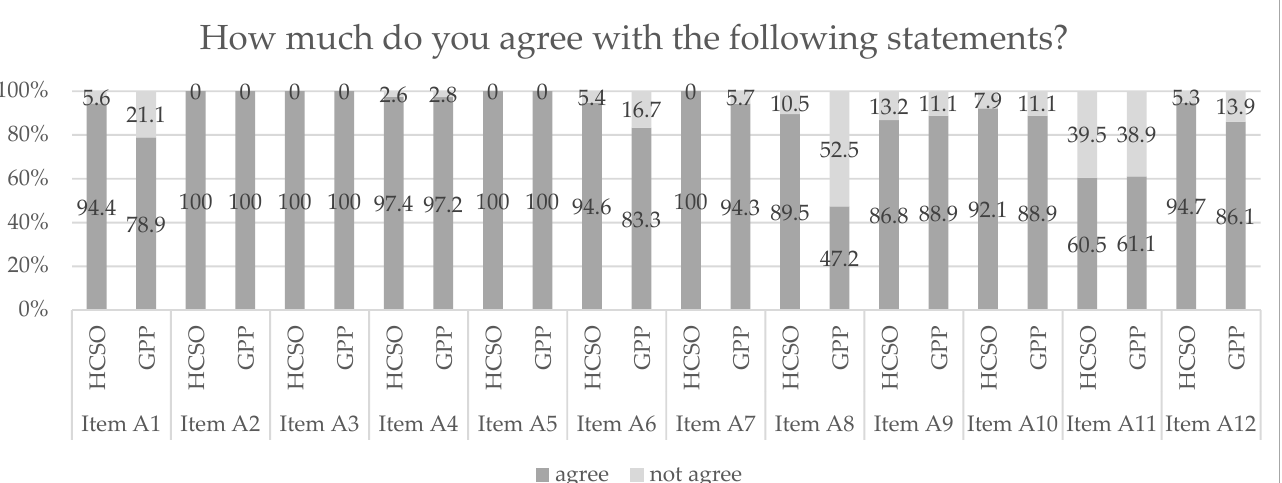
Table 4. Analysis of the OHL Self-AsseT checklist filled out by the self-assessment teams of the home care service organization (HCSO) and the general practitioners’ practices (GPPs). The values range between 0%, indicating no fulfillment of the corresponding criteria, and 100%, indicating that the criteria were completely fulfilled by the organization, according to the self-assessment teams. Dimensions of a Health Literate Organization